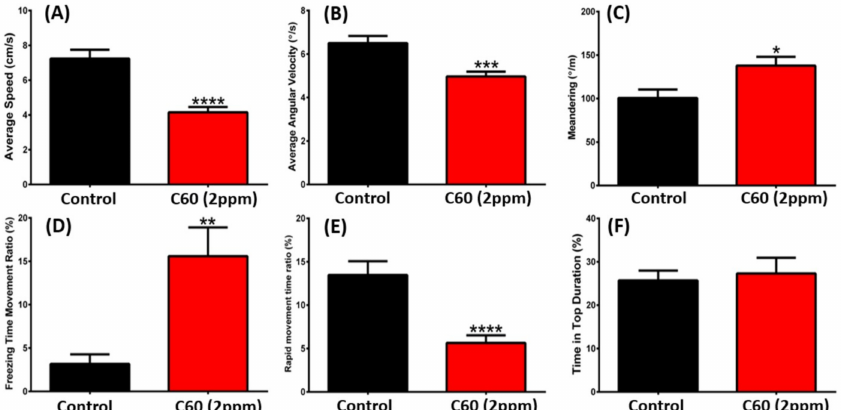
Figure 4. Comparison of behavior endpoints between wild-type and C 60 NPs-exposed zebrafish in 3D locomotion test after five-day exposure. ( A ) Average speed, ( B ) average angular velocity, ( C ) meandering, ( D ) freezing time movement ratio, ( E ) rapid movement time ratio, and ( F ) time in top duration were analyzed. The data are expressed as the mean ± SEM and were analyzed by t -test ( n = 18 for control; n = 30 for C 60 NPs-exposed fish; * p < 0.05, ** p < 0.01, *** p < 0.005, **** p <